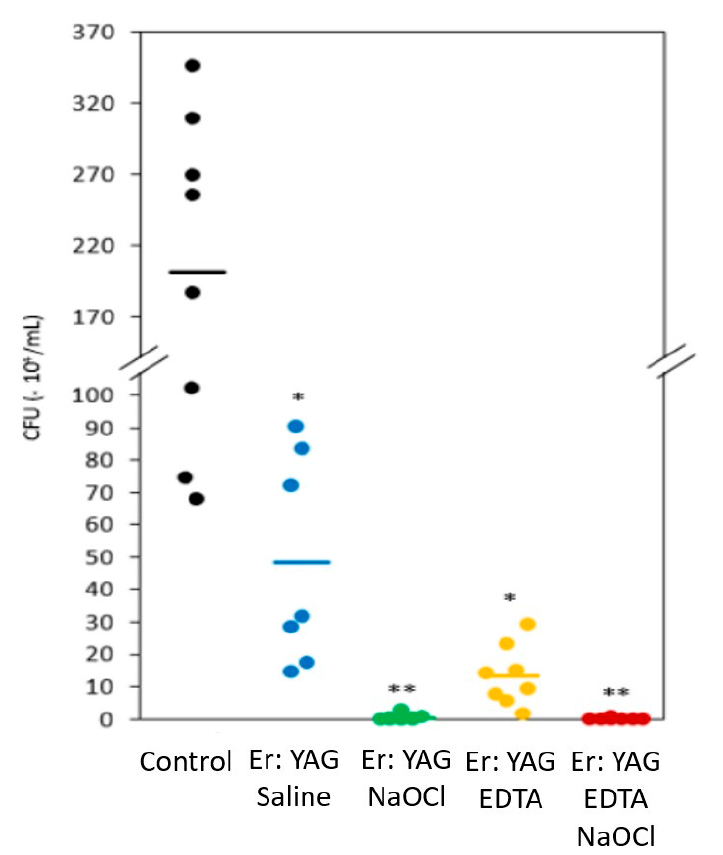
Figure 4. The number of E. faecalis colonies after treatment on infected teeth with Er:YAG laser-Endo tip and different irrigation solutions in comparison to the control group. Group 1: The CFU of E. faecalis in control infected samples without treatment (black). Group 5: The CFU of E. faecalis after using an Er:YAG laser-Endo tip and saline (blue). Group 4: The CFU of E. faecalis after using an Er:YAG laser-Endo tip and a 2.5% NaOCl irrigation (green). Group 3: The CFU of E. faecalis after using an Er:YAG laser-Endo tip and a 17% EDTA irrigation (yellow). Group 8: The CFU of E. faecalis after using an Er:YAG laser-Endo tip and a 17% EDTA irrigation, followed by a 2.5% NaOCl irrigation (red). N = 8 in each group. * p < 0.01 for treated samples compared to control. ** p < 0.001 for treated samples compared to control.